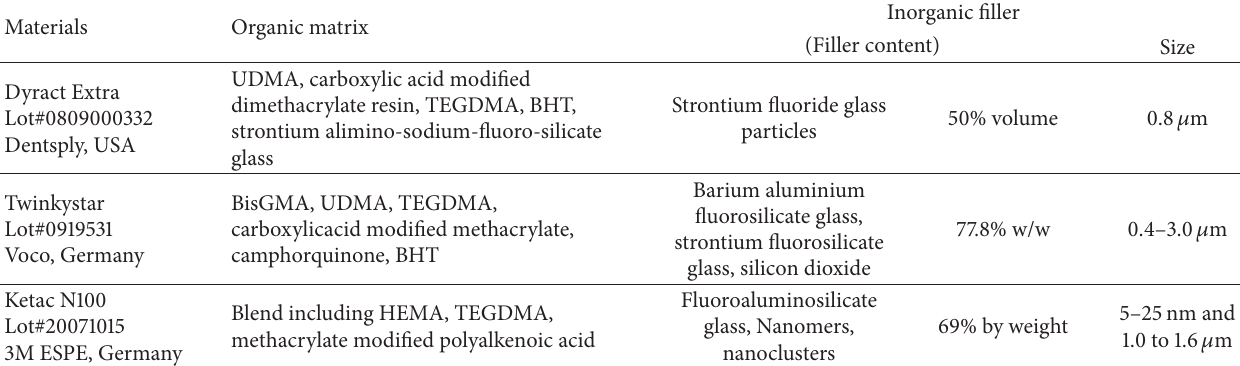
Table 1: Composition of the resin modified glass ionomer cement and compomers used in this